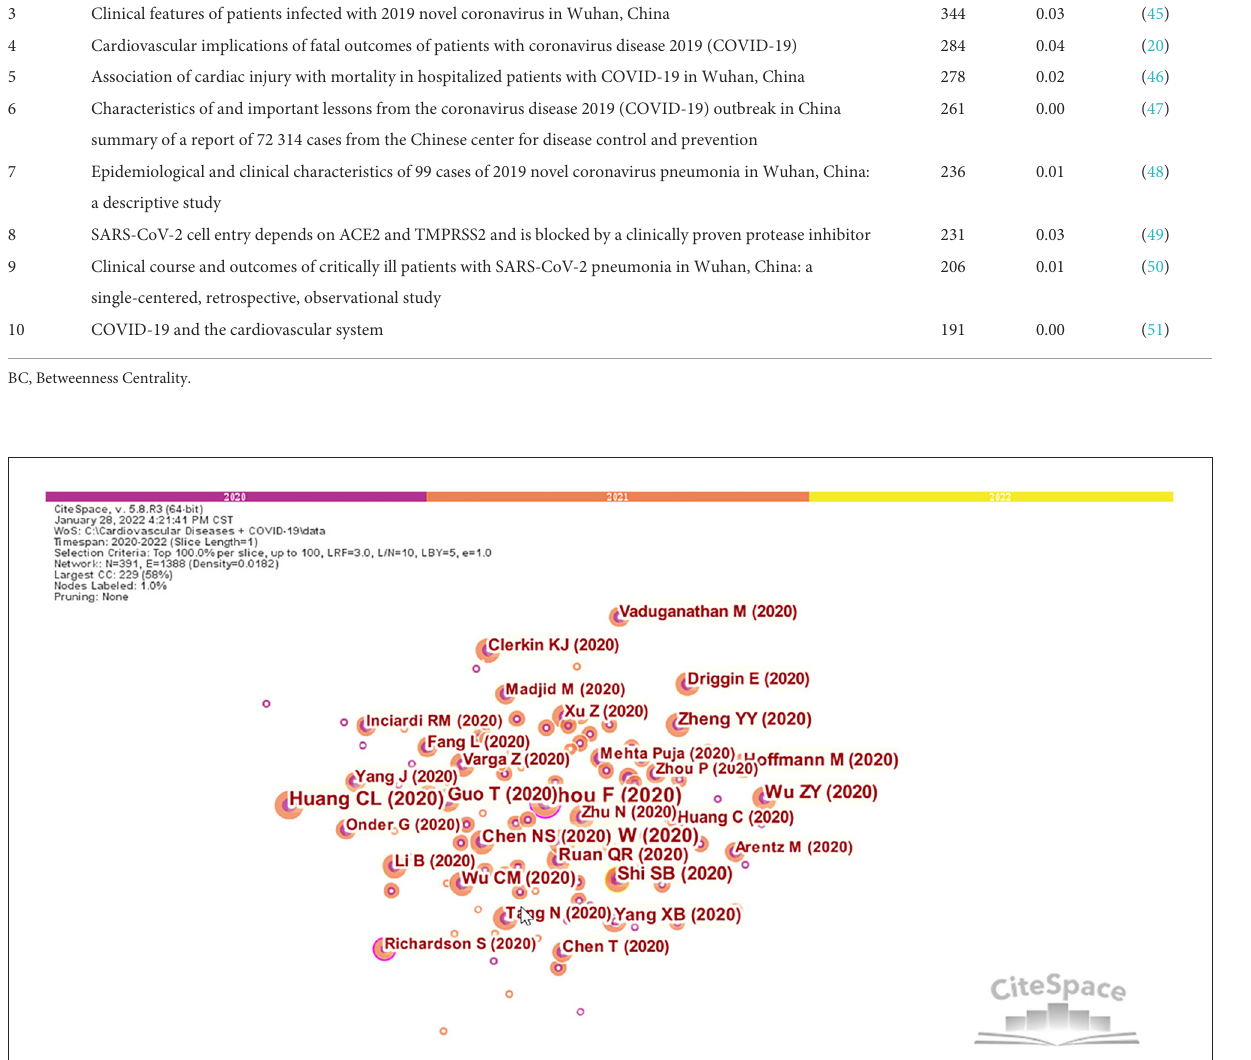
duration of virus detoxification was 37 days (43). This also partly explains why some patients have nucleic acid reactivation after